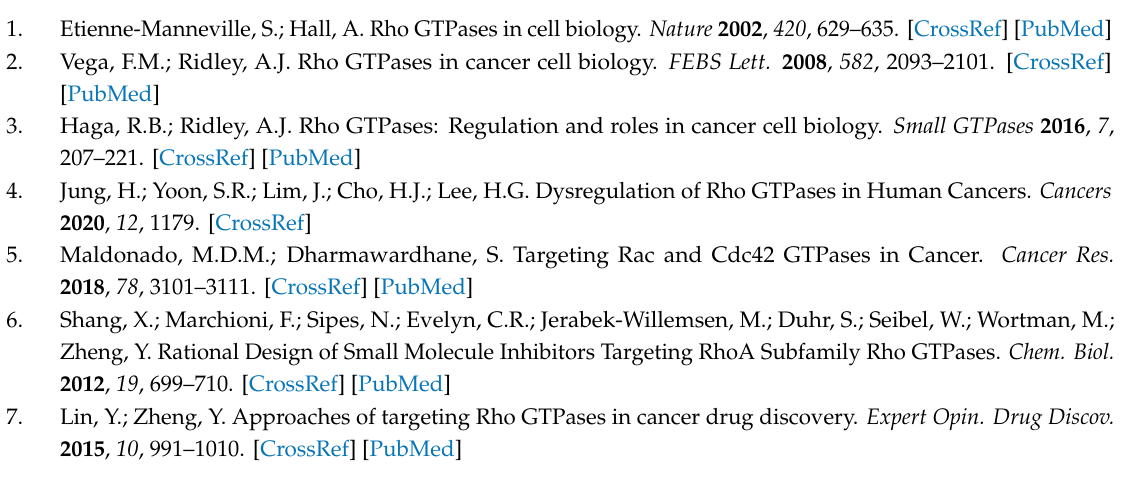
Figure S1: Full multiple sequence alignment (MSA) of START domains from DLC-1, DLC-2, and DLC-3 orthologs. Figure S2: DLC-1 R988 and DLC-2 R1010 residues and interactions. Tables S1–S7 in